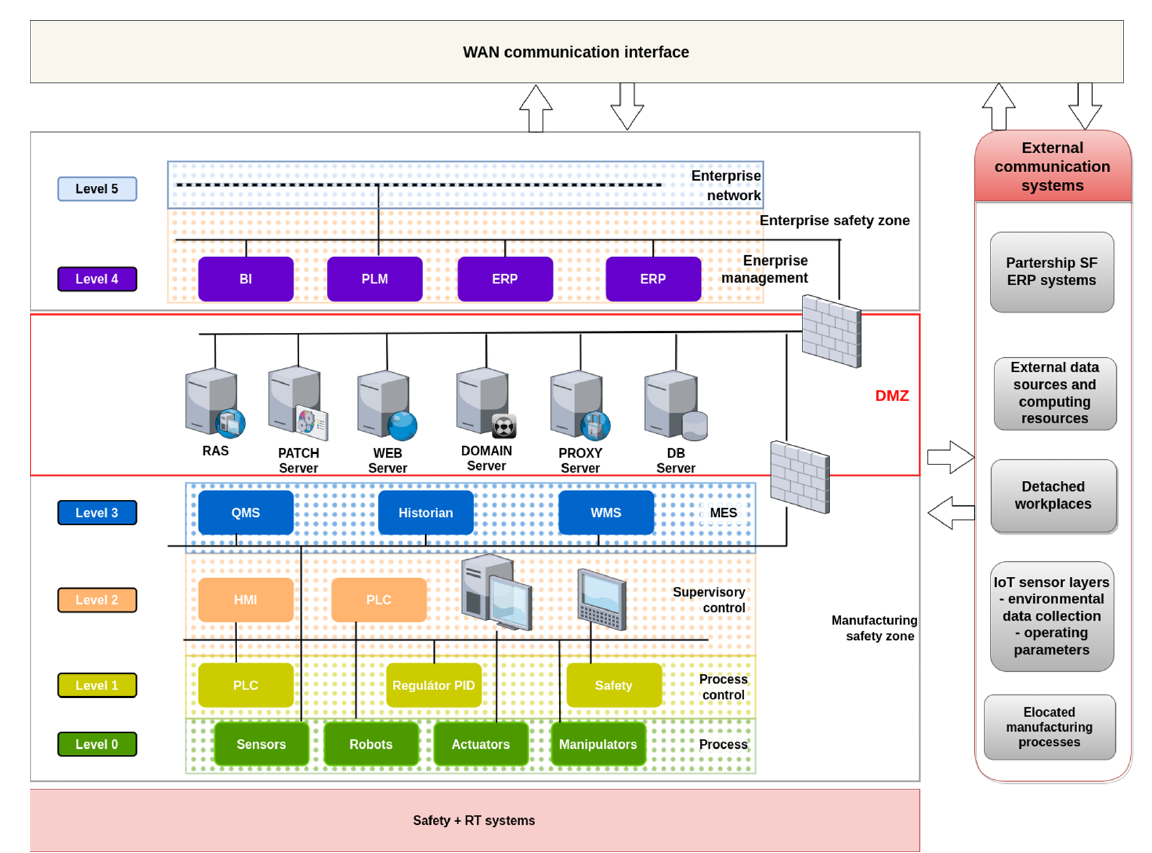
Figure 14. The enhanced model of a production system based on the PERA model.